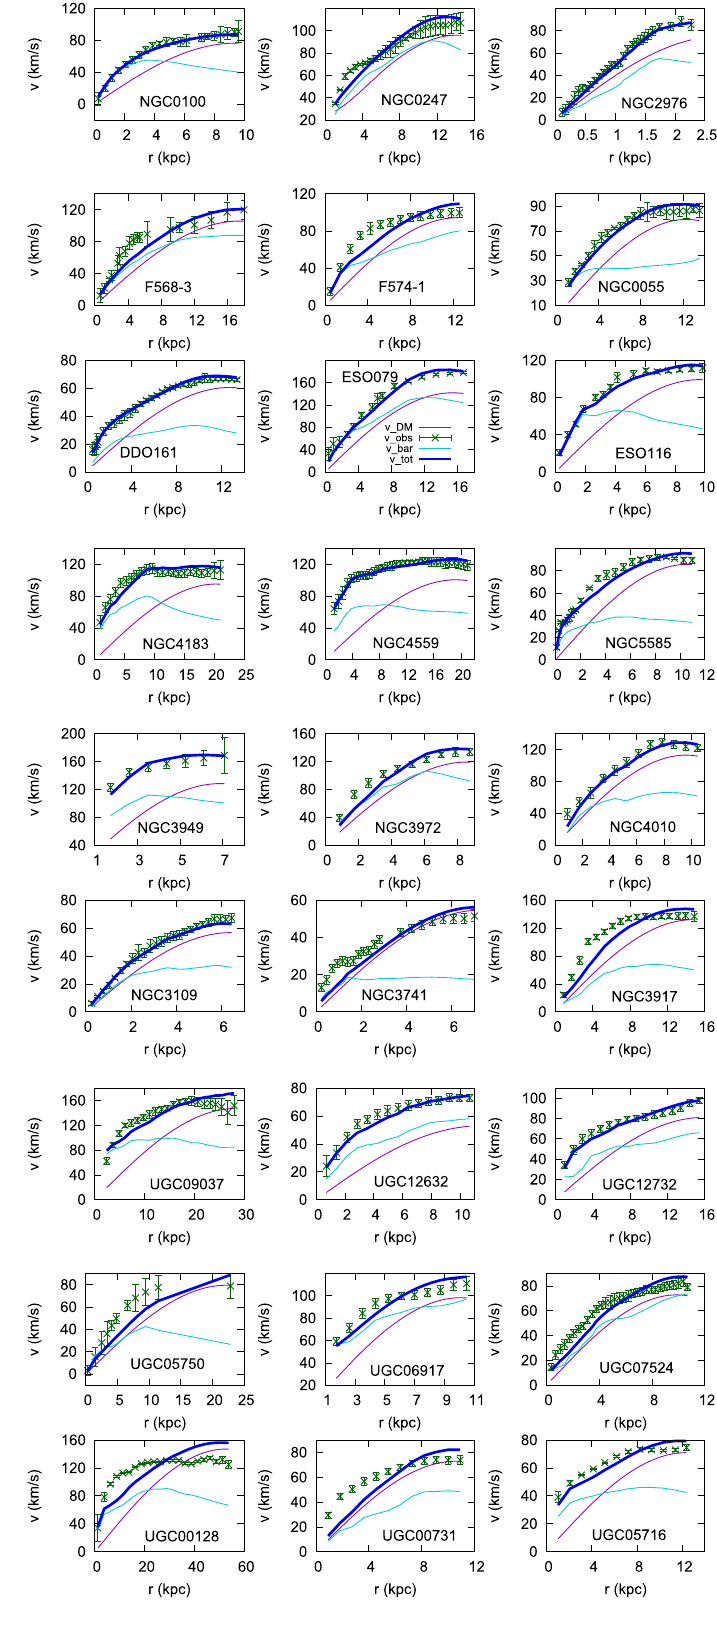
Fig. 5 Comparison of the theoretical predictions for the galactic rotation of the random Bose–Einstein Condensate dark matter model with 27 SPARC galaxies without bulge velocity. In the Figures v obs , v bar , v DM and v tot are represented by the dark - green, the dark - turquoise, the dark - violet, and the blue curves,